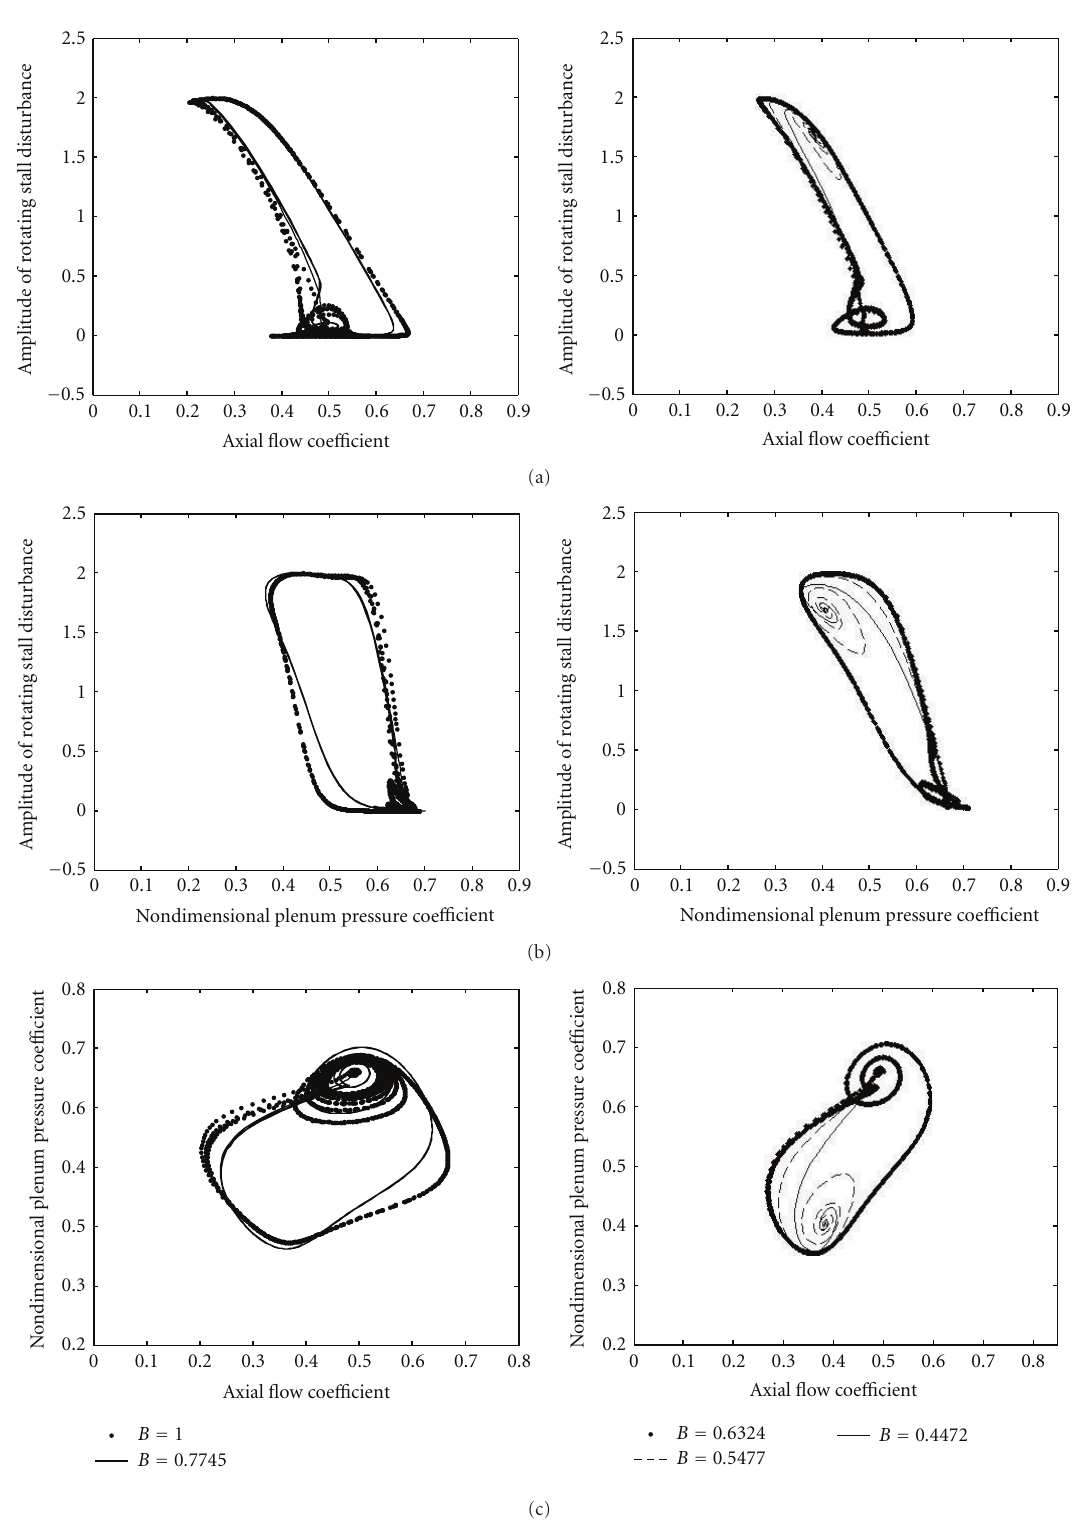
Figure 5: E ff ect of decrease in plenum size: (a) variation of axial flow coe ffi cient with disturbance amplitude of rotating stall. (b) Variation of plenum pressure rise coe ffi cient with disturbance amplitude of rotating stall. (c) Limit cycle oscillation: axial flow coe ffi cient versus plenum pressure rise coe ffi